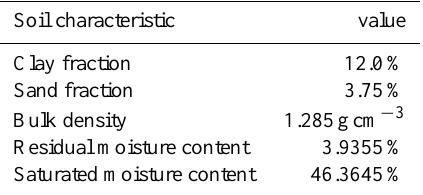
Table 1. Soil characteristics of the agricultural field considered.